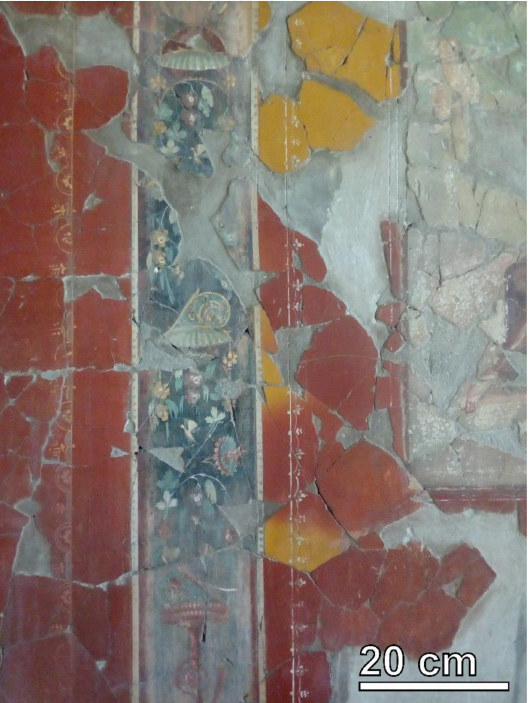
Figure 4. Detail of a portion of the east wall of the tablinum, with evident signs of temperature- induced chromatic alteration of the original yellow